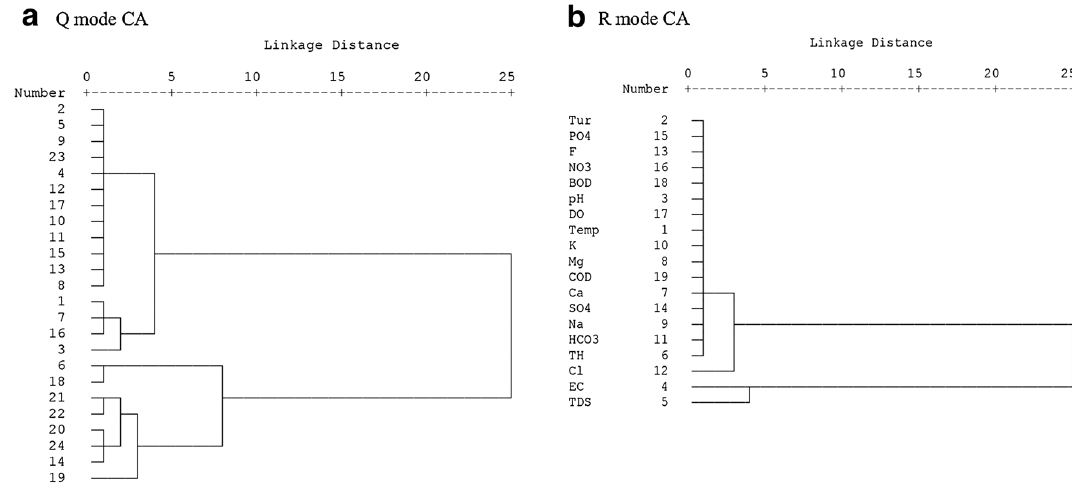
Fig. 10 a , b Dendrogram of Q and R-mode hierarchical cluster analysis (May 2013)